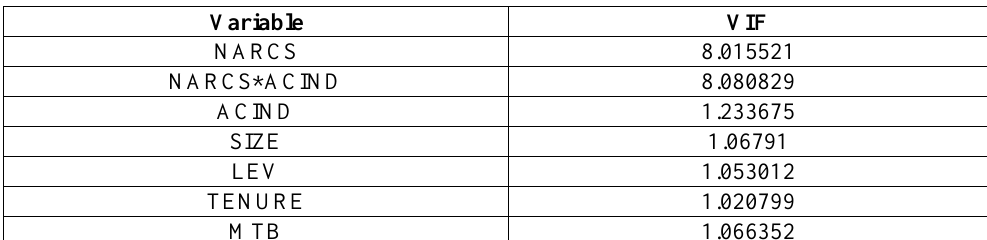
Table 4. Collinearity between the